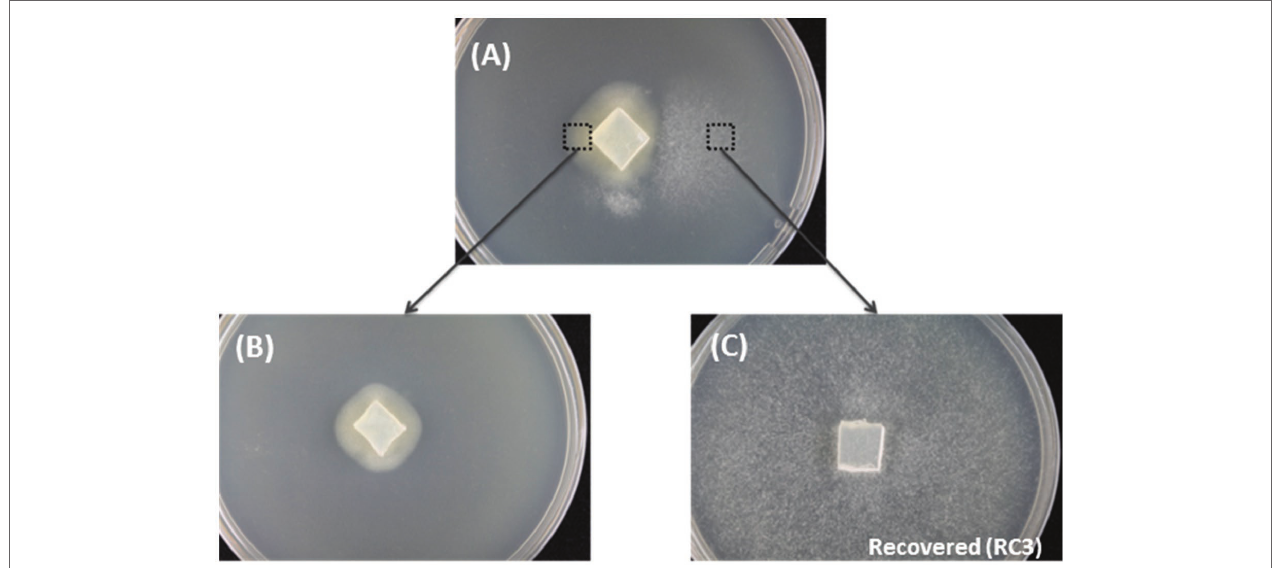
FIGURE 1 | The spontaneous recovery of HetPV13-an1 infected fungal isolate as shown by mycelial morphology. (A) The original mycelium with slow and fast growth on the left and right side of the dish, respectively. (B) Mycelia transferred from the left side of the original mycelium. (C) Recovered 94233-RC3 transferred from the right side of the original